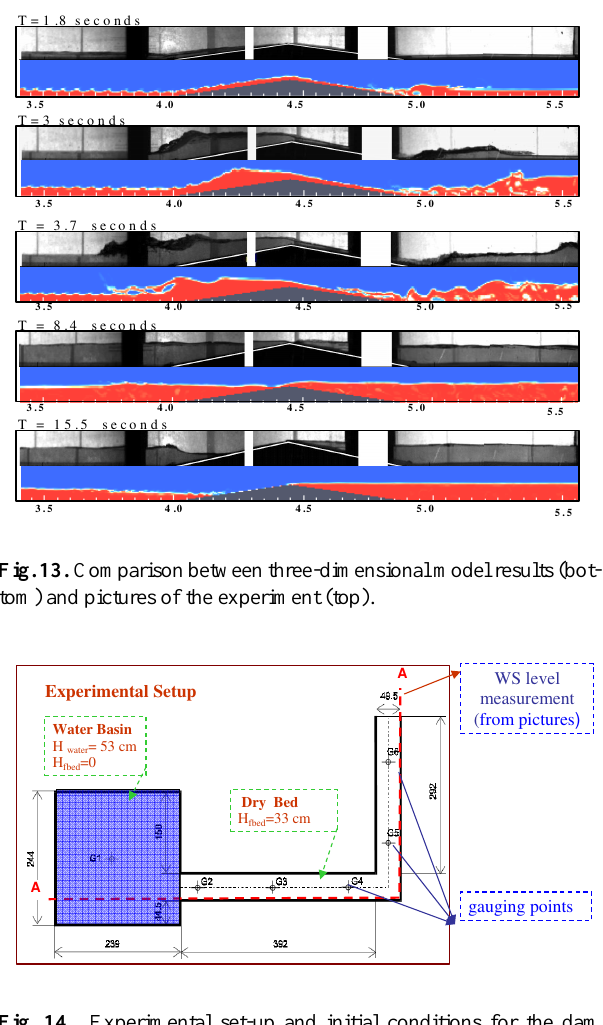
At t =5 s the downstream front has almost reached the free end of the channel (Fig. 15b).